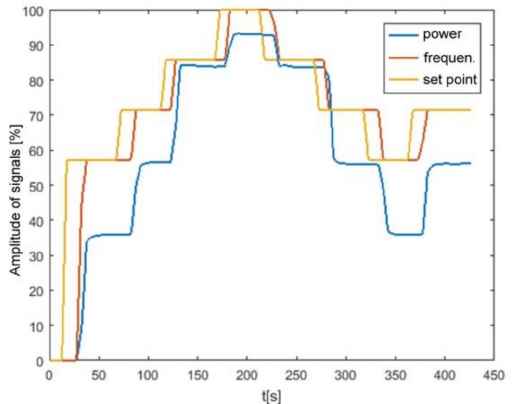
Figure 15. Example of response of the direct layer control system regulating frequency of the inverter which supplies electromagnetic